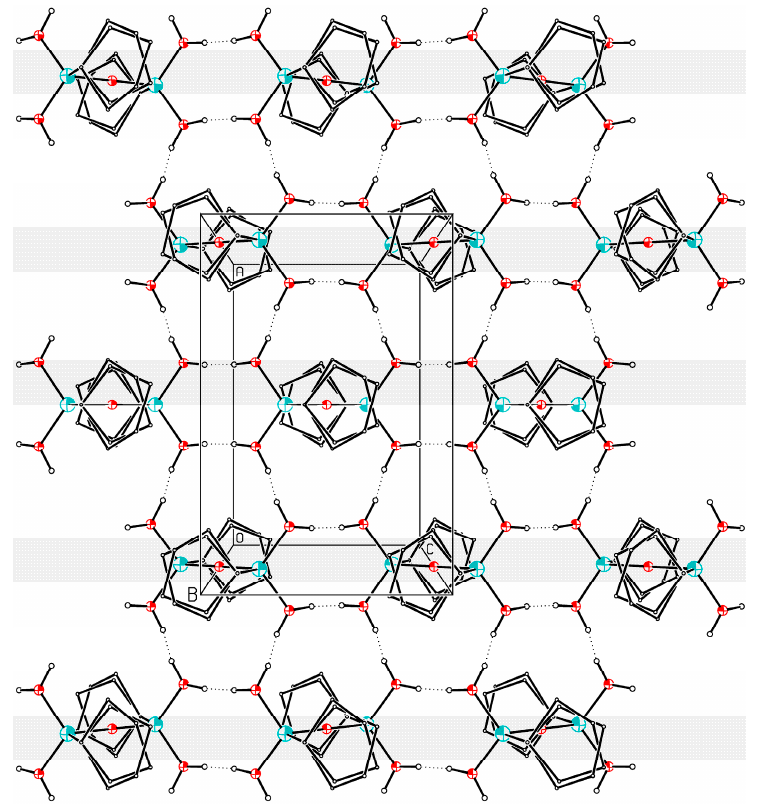
Figure 2. ORTEP plot of the orthorhombic packing of 2 . The atoms are drawn with arbitrary radii, the hydrogen bonds are plotted with dashed lines. Red: oxygen; blue: silicon.